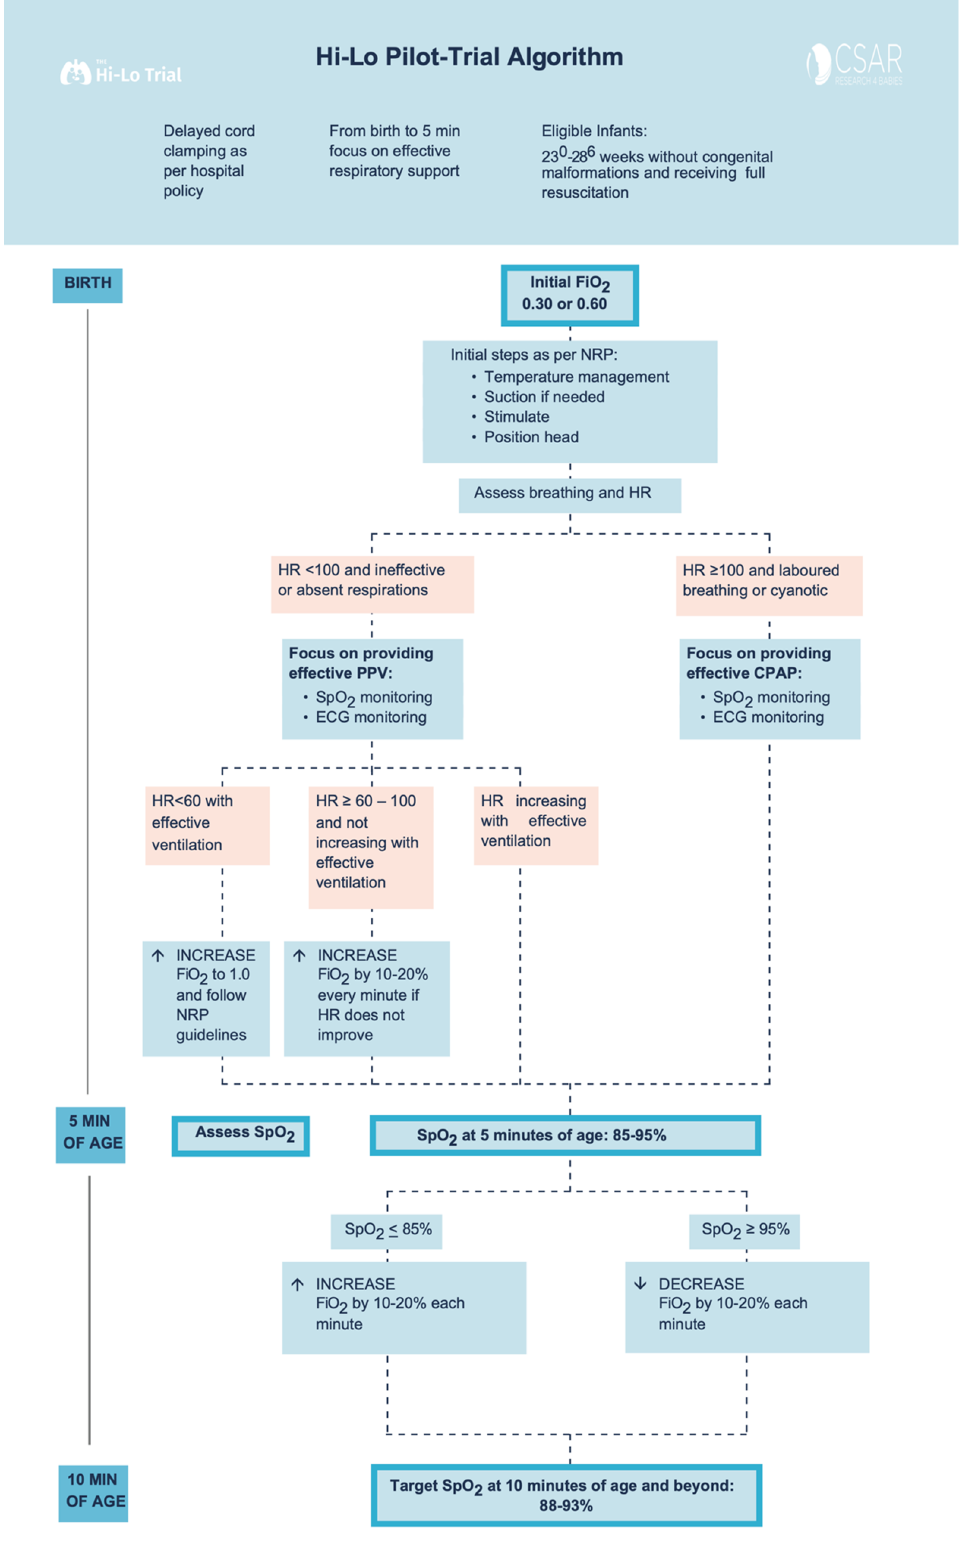
Figure 1. Study Interventions Flowchart. Infants remained in 30% or 60% O 2 until 5 min of age unless the infant’s heart rate